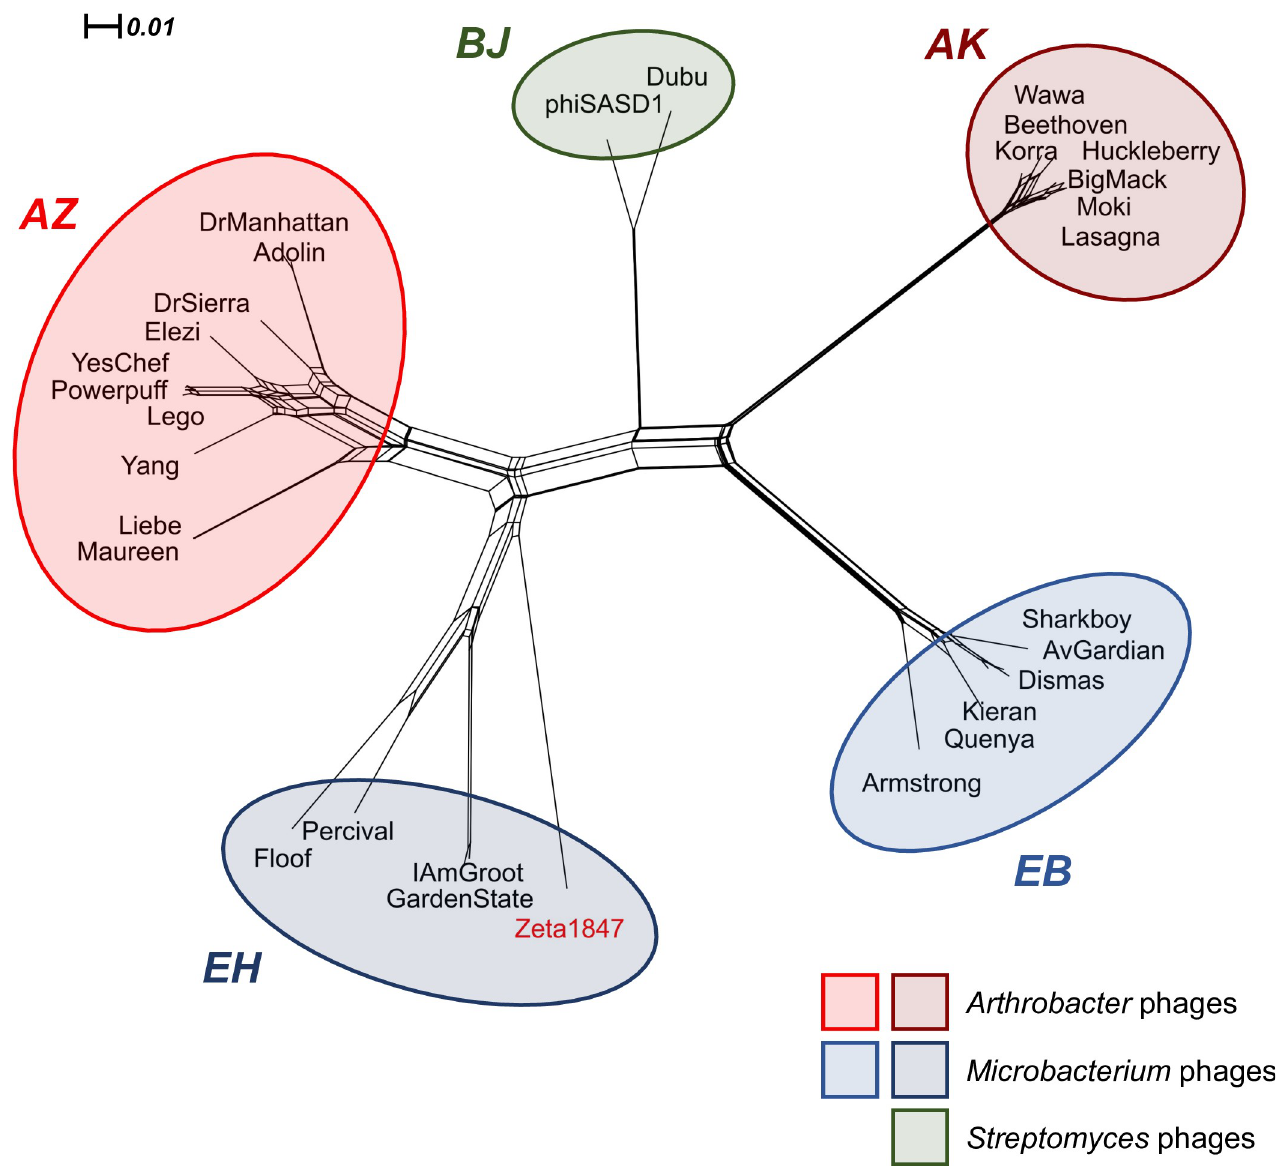
Fig 7. Cluster AZ is more similar to Microbacterium and Streptomyces phages than to any other Arthrobacter phages. Pham information was obtained from the Actino_Draft database (version 382) and input into SplitsTree 4.16.1 to produce a network phylogeny using default parameters. Phage clusters are colored by host as indicated in the legend. The former singleton Zeta1847 is indicated in red. Each cluster formed a distinct branch on the tree. The most distant group of phages from Cluster AZ comprised Cluster AK, indicating low gene similarity despite being the most closely related Arthrobacter phages according to